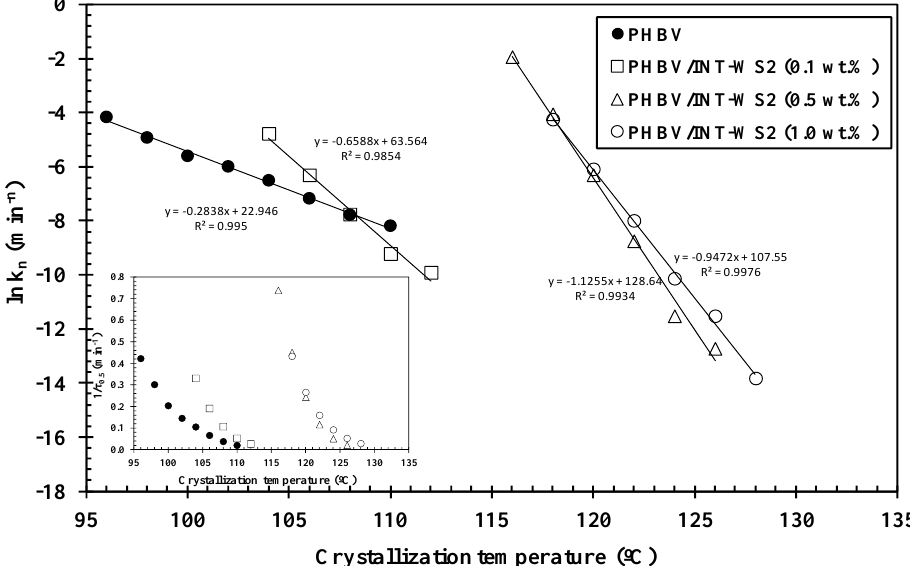
Figure 3. Logarithmic plots of the global rate constant ( k ) of PHBV/INT-WS 2 nanocomposites as a function of the crystallization temperature ( T c ); the inset represents the inverse of crystallization half-time (1/ τ 0.5 ) as a function of T c .